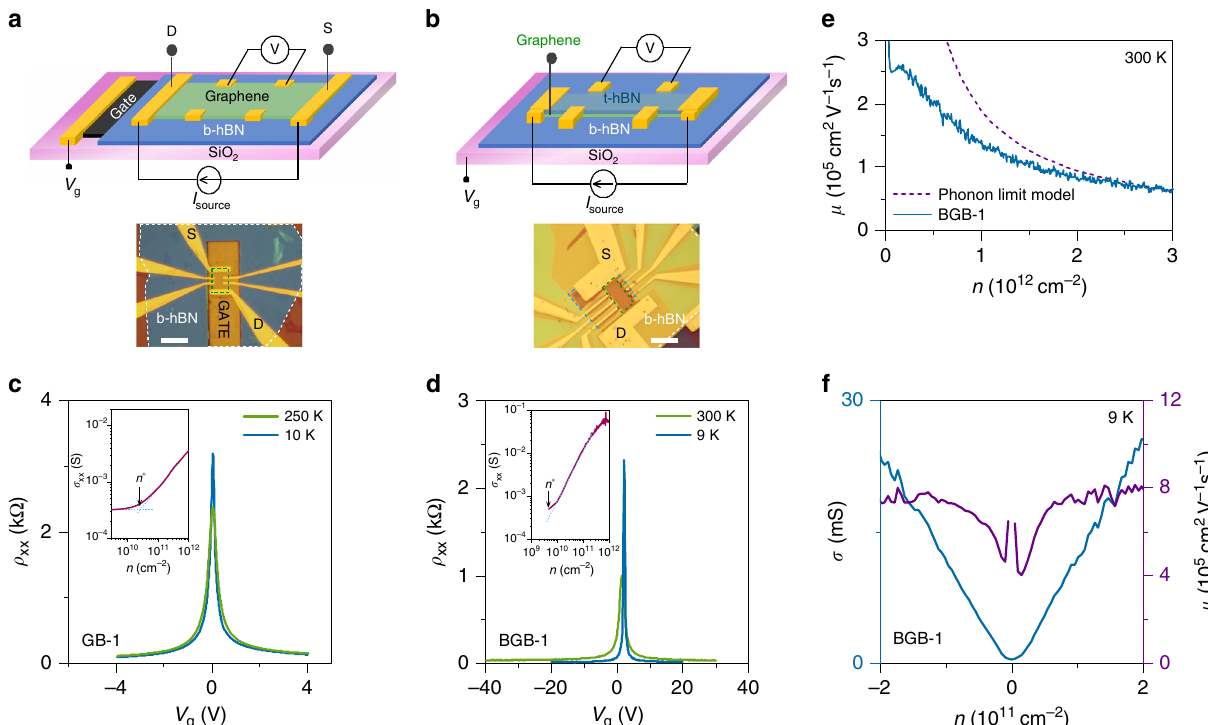
Fig. 4 Transport characteristics of graphene heterostructures. We fabricated gated-Hall bar devices from two types of graphene heterostructures: a graphene-on-hBN (GB) and b graphene encapsulated in hBN (BGB). The dashed green box in the optical images shows the device active region. The scale bars are 10 μ m. The narrow FWHM of the four-point longitudinal resistivity ( ρ xx ) of the c GB and d BGB devices suggests a low-charge inhomogeneity ( n * ) in graphene. The insets in c and d show the estimated n * of the GB and BGB devices. e The carrier-density-dependent mobility of the BGB-1 device at room temperature, giving mobility in excess of 200,000 cm 2 V − 1 s − 1 at low carrier densities. For comparison, we provided the theoretically predicted acoustic phonon-limited mobility 45 . f The corresponding low-temperature mobility of the BGB-1 device is 800,000 cm 2 V − 1 s − 1 at low carrier